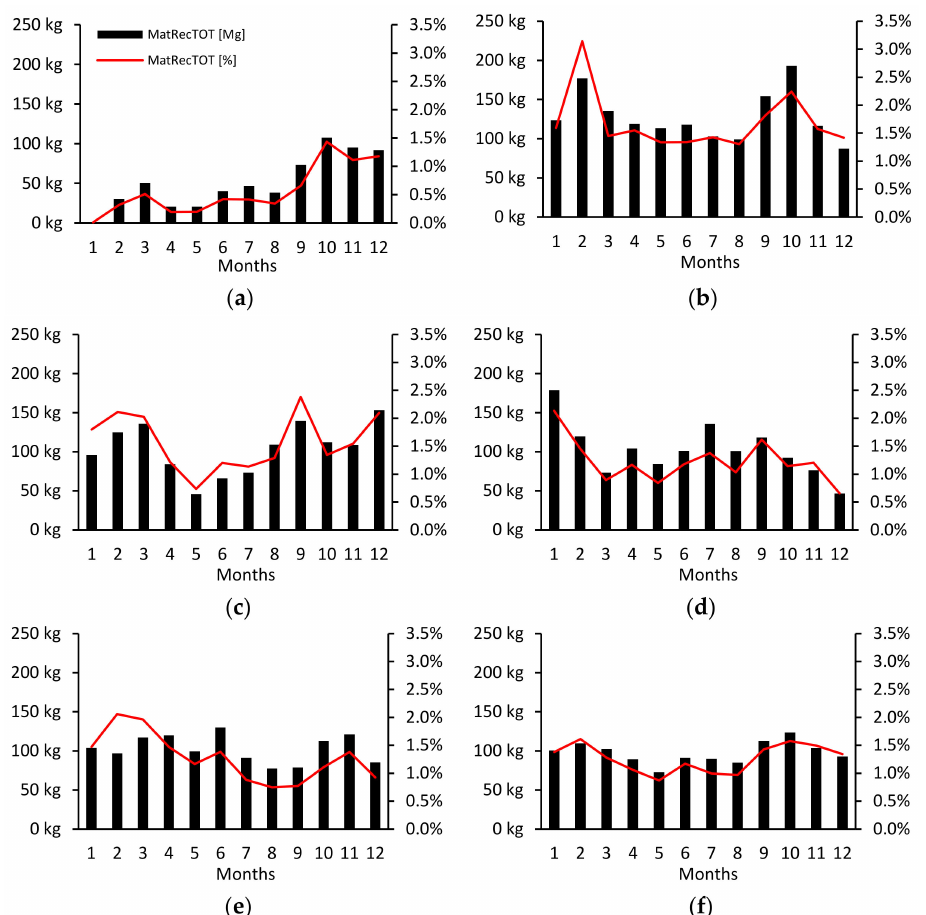
Figure 6. Monthly mass of commercial assortments sorted during the mechanical and biological treatment of municipal waste in 2016–2020; ( a ) 2016; ( b ) 2017; ( c ) 2018; ( d ) 2019; ( e ) 2020; ( f ) average for